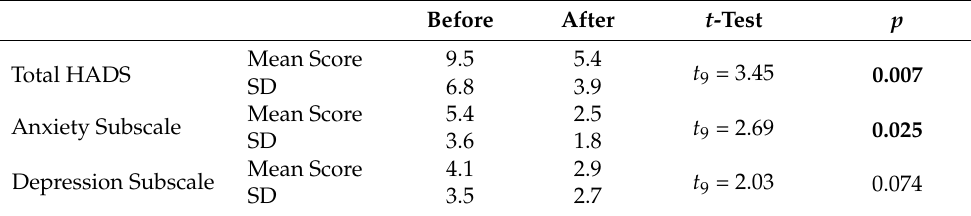
Table 2. Differences in anxiety and depression scores before and after blackcurrant therapy. Before After t -Test p Mean Score 9.5 Total HADS Mean Anxiety Subscale